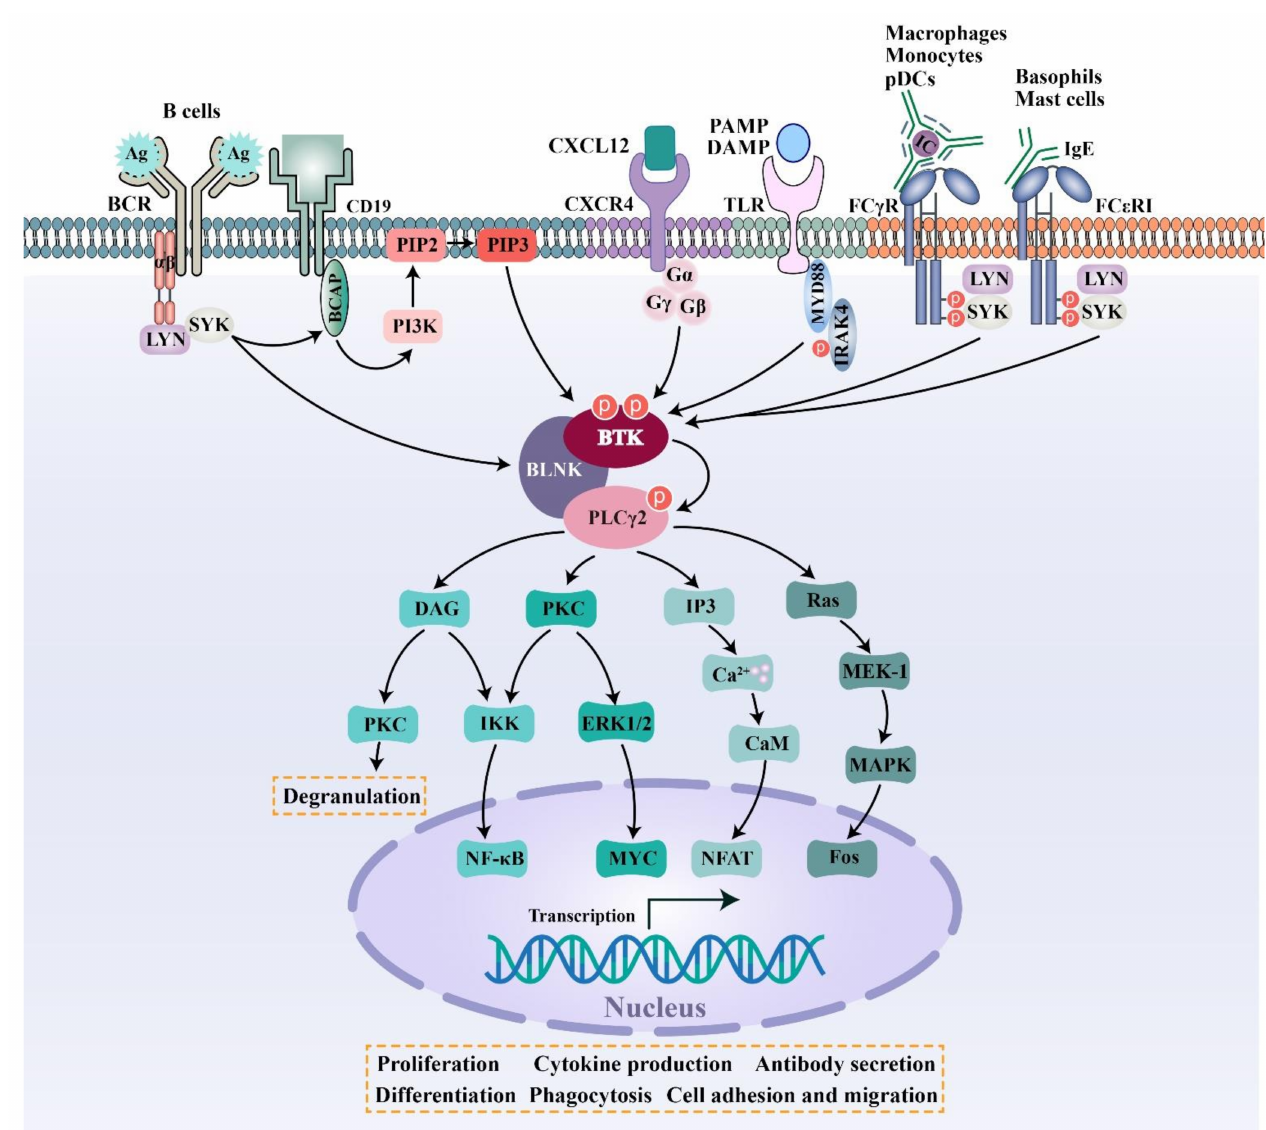
Figure 2. BTK regulates multiple receptor signaling pathways including those of the B-cell receptor (BCR), Fc receptor (FcR), Toll- like receptor (TLR) and chemokine